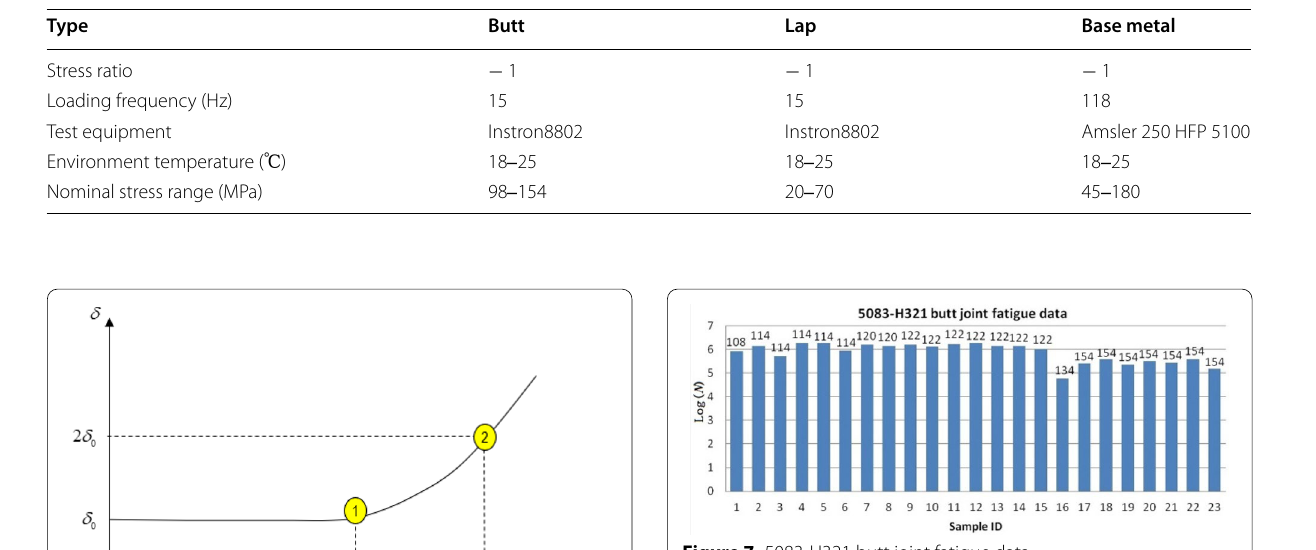
Table 2 Basic parameters of fatigue test